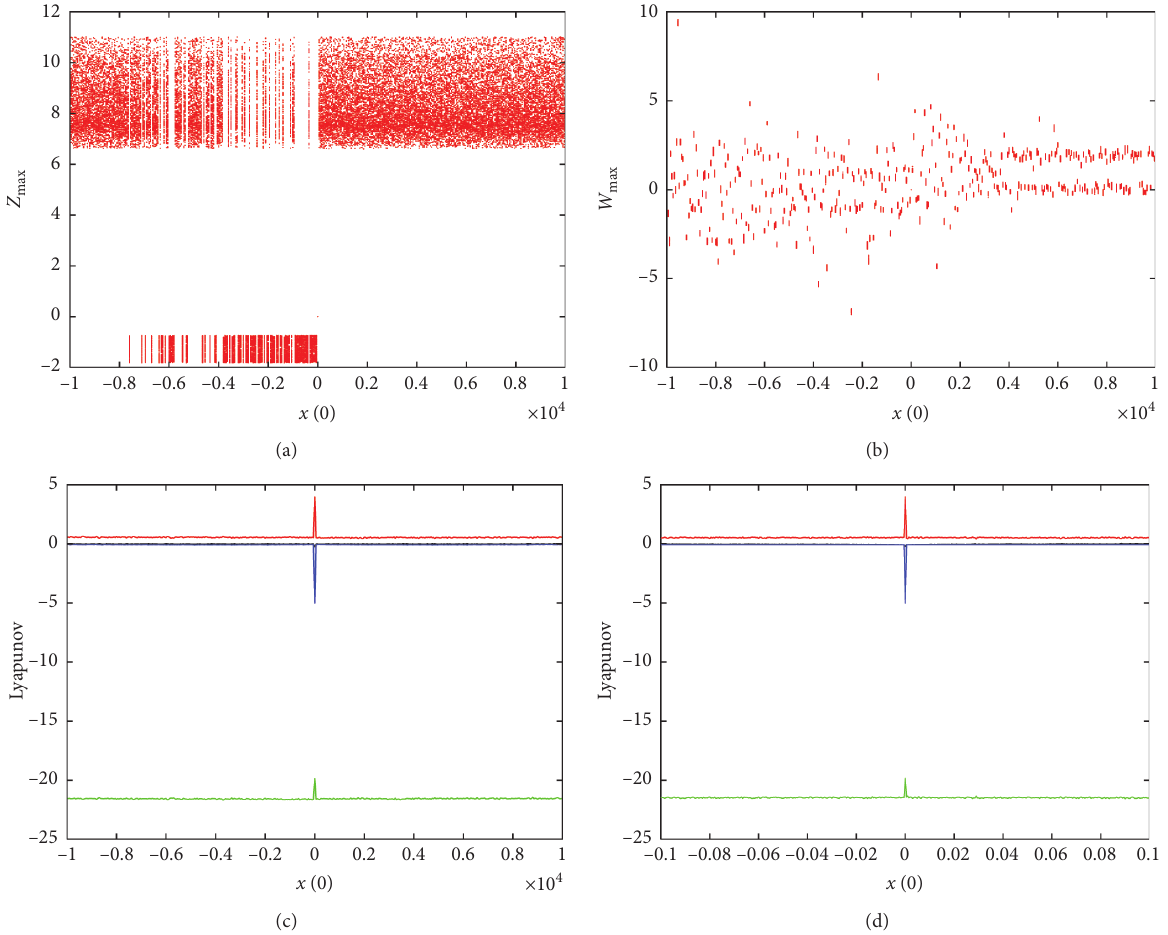
Figure 8: (a) Bifurcation diagram of the state variable z , (b) bifurcation diagram of the state variable w , (c) Lyapunov spectrum with respect to initial condition x ( 0 ) in the region [− 10 4 , 10 4 ] , and (d) Lyapunov spectrum with respect to initial condition x ( 0 ) in the region [− 0 . 1 , 0 . 1 ]